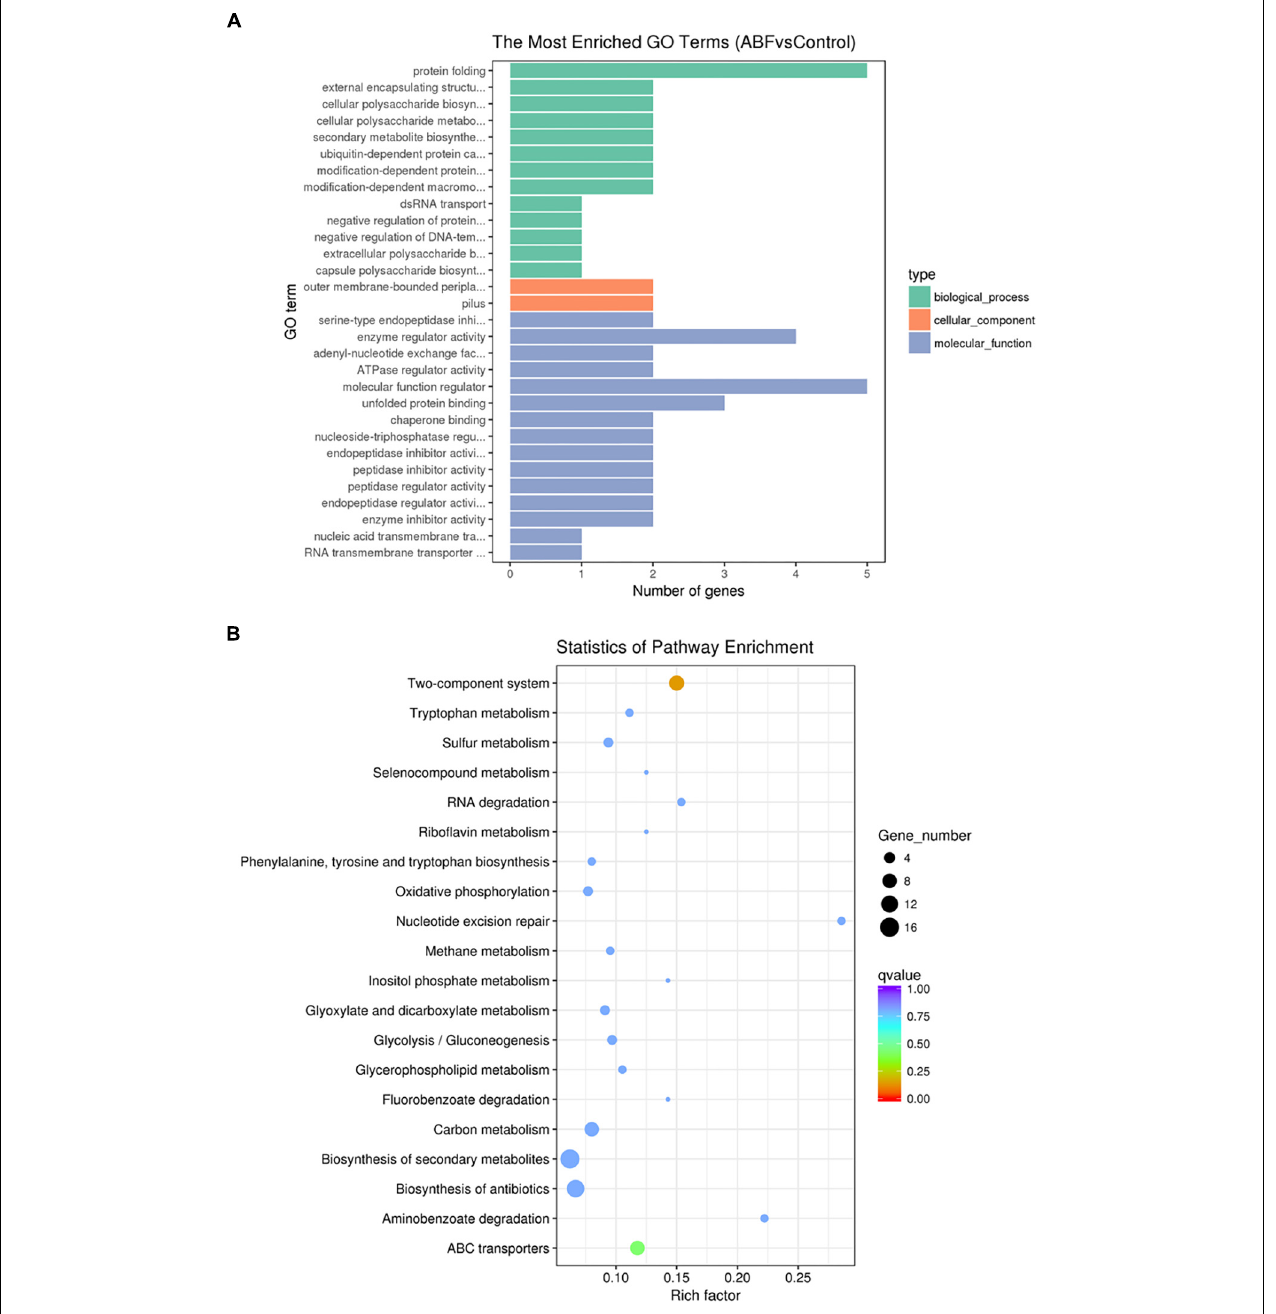
FIGURE 6 | (A) Gene Ontology (GO) analysis of differentially expressed genes. (B) Statistical enrichment of differentially expressed genes in KEGG